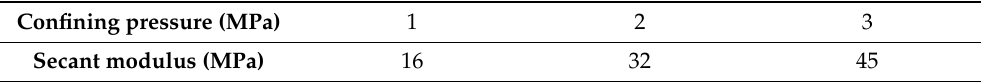
Table 1. Secant modulus for sediments without